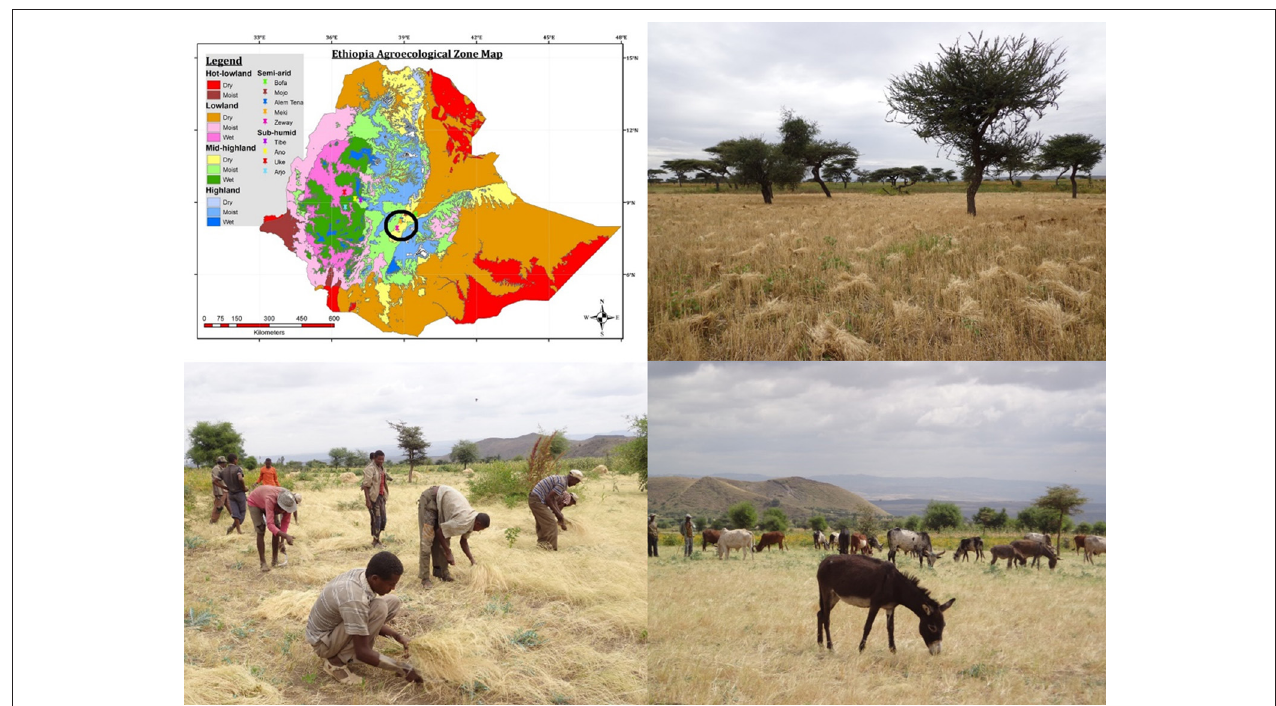
FIGURE 4 | Ethiopian site illustration. Trees on farms are characteristic of a large part of the Ethiopian agricultural landscape where farmers usually retain trees of selected species and minimize impact on the companion crops through occasional lopping and pollarding. While cropping plots belong to individual farmers, neighboring farmers collectively practice harvesting immediately after which communal grazing is